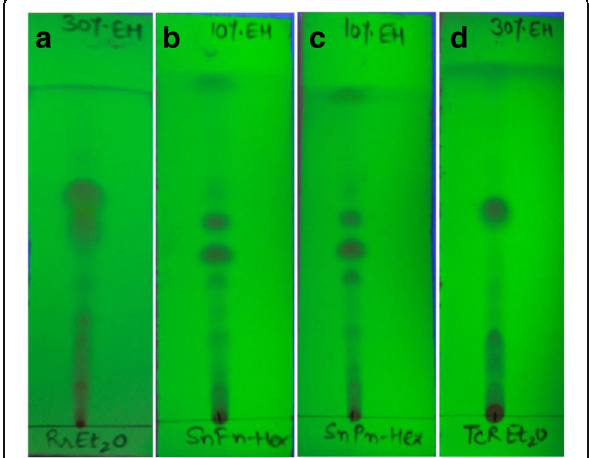
Fig. 1 Thin Layer Chromatography (pre-coated silica TLC plates) profile of bioactive fractions: a diethyl ether fraction of Rr Roots; b n - Hex fraction of Sn Flower; c n - Hex fraction of Sn Pseudobulb and ( d ) diethyl ether fraction of Tc Roots The TLC plates were developed in solvent system of varying polarity, i.e. ethyl acetate: n -Hexane (1:9, 3:7 and 1:1), [EH]. The plates were observed under UV light (254